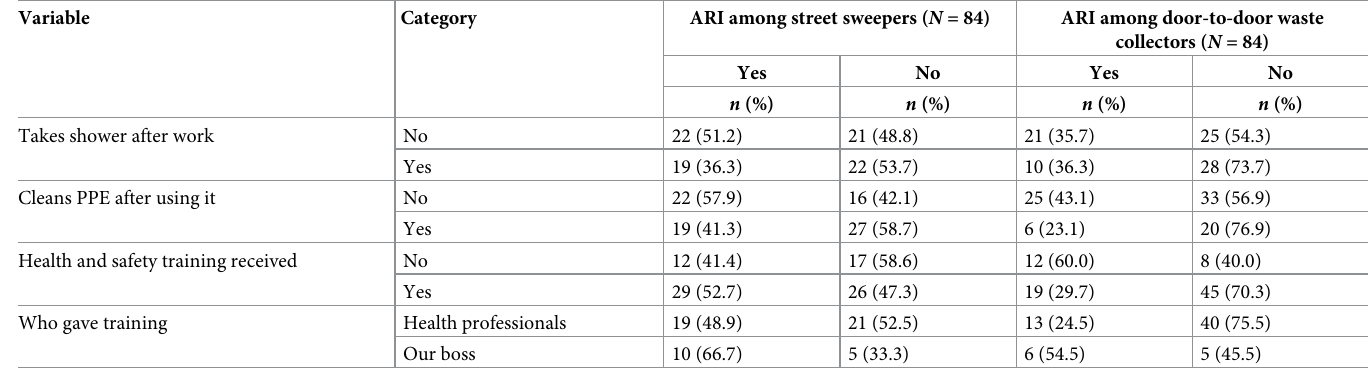
Table 2. Cleaning personal protective equipment (PPE), taking shower after work and training among street sweepers and door-to-door waste collectors in Dessie City, Ethiopia March to May 2018. Variable Category ARI among street sweepers ( N =